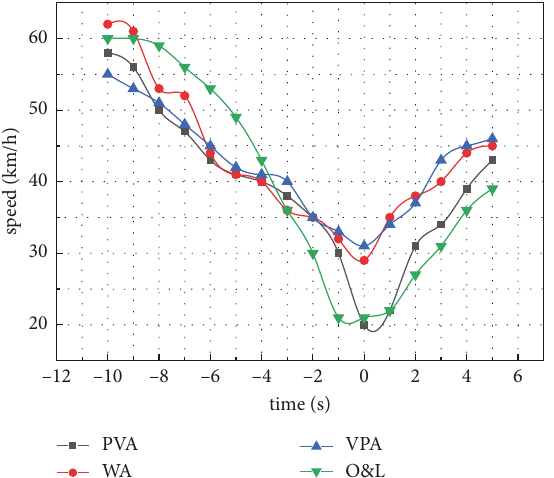
Figure 10: Speed change curve at different types of random risk